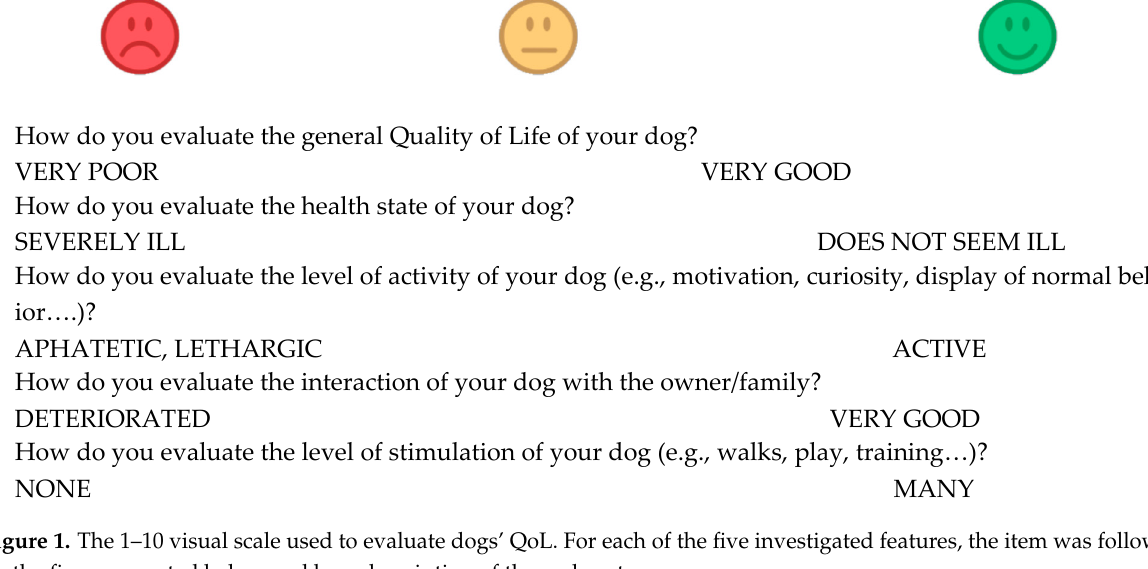
Figure 1. The 1–10 visual scale used to evaluate dogs’ QoL. For each of the five investigated features, the item was followed by the figure reported below and by a description of the scale extremes.